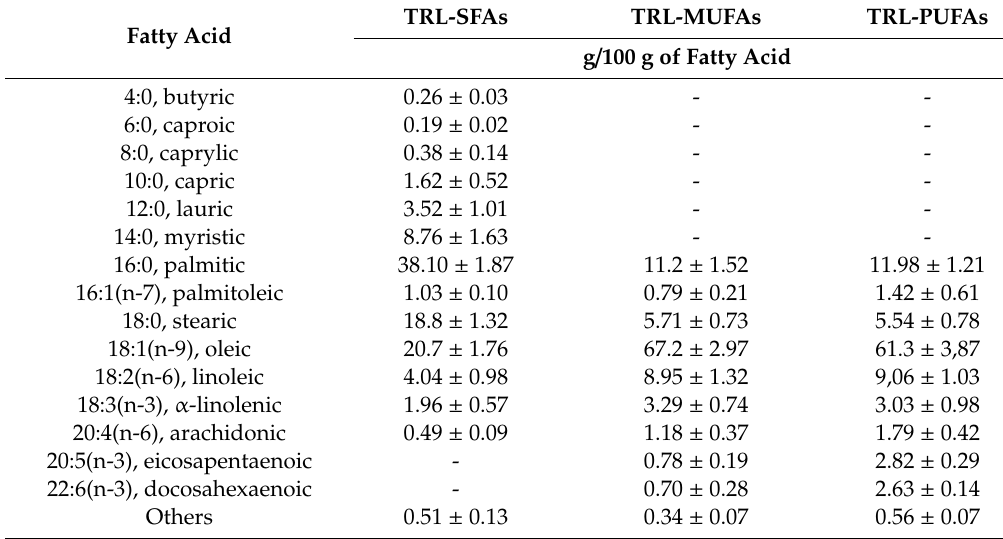
Table 1. Fatty acid composition of postprandial